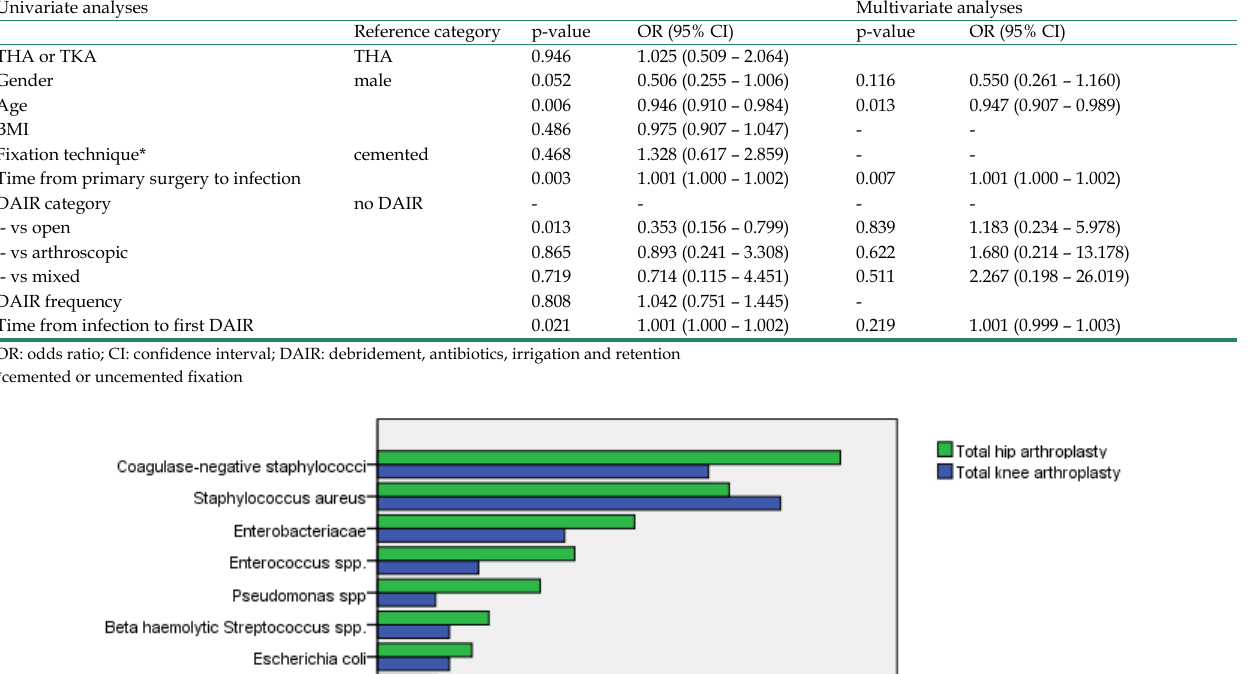
Table 2. Results from univariate and multivariate logistic regression analysis prediction revision surgery within 1 year after infection. Univariate analyses Multivariate analyses Reference category